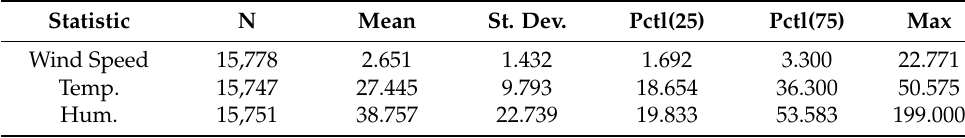
Table 3. Descriptive statistics of the air